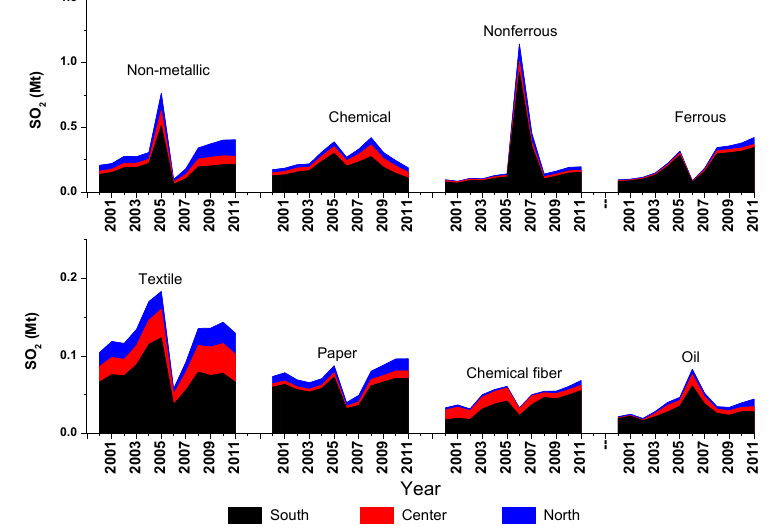
Figure 5. Spatial variations of the SO 2 emissions of different manufacturing subsectors in Jiangsu province during 2000–2011.